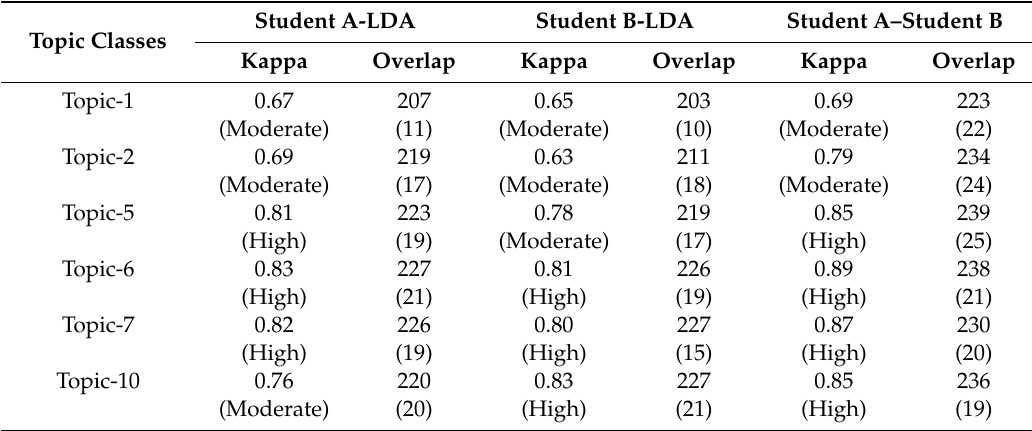
Table 3. Reliability Assessment of LDA model using Cohen’s Kappa coe ffi cient.